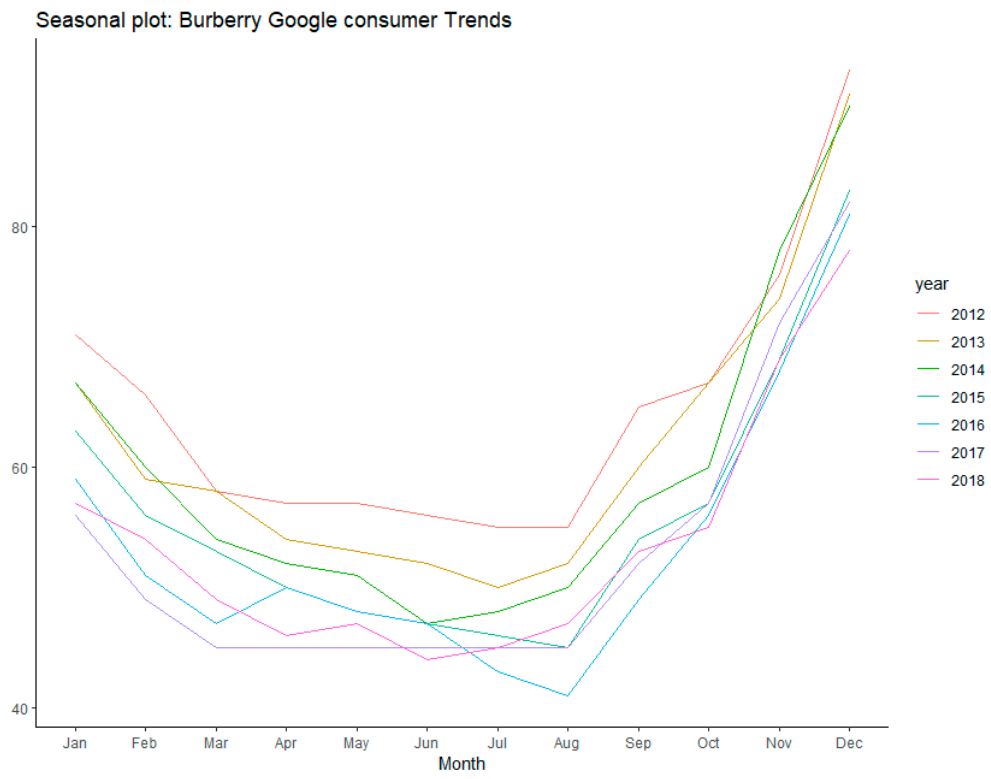
Figure 8. Seasonal plot of “Burberry” Google Trends (January 2012–December 2018). (Data Source: Google Trends, 10 February 2019).